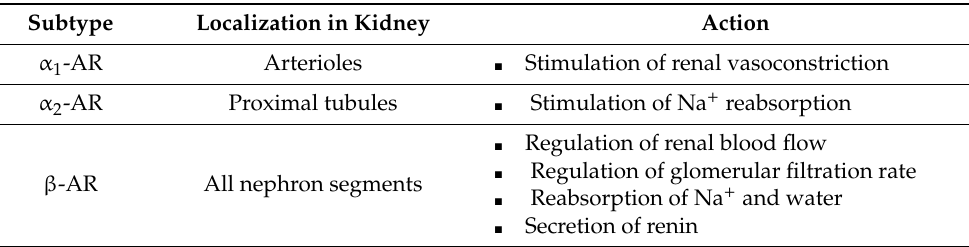
Table 1. Localization and action of adrenergic receptors in the